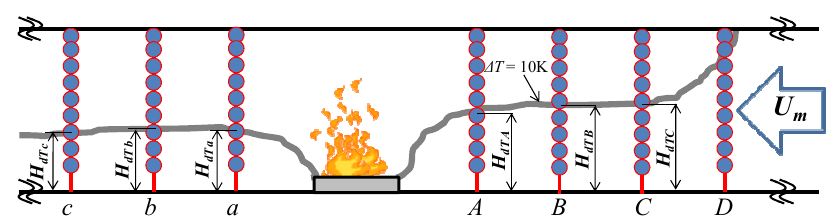
Fig. 9 Definition of the height of the thermal fumes: H dT shows the smoke layer height defined by the temperature rise ( δ T = 10 K). Position D at the thermal fume tip was excluded from the definition of the height of the thermal fumes